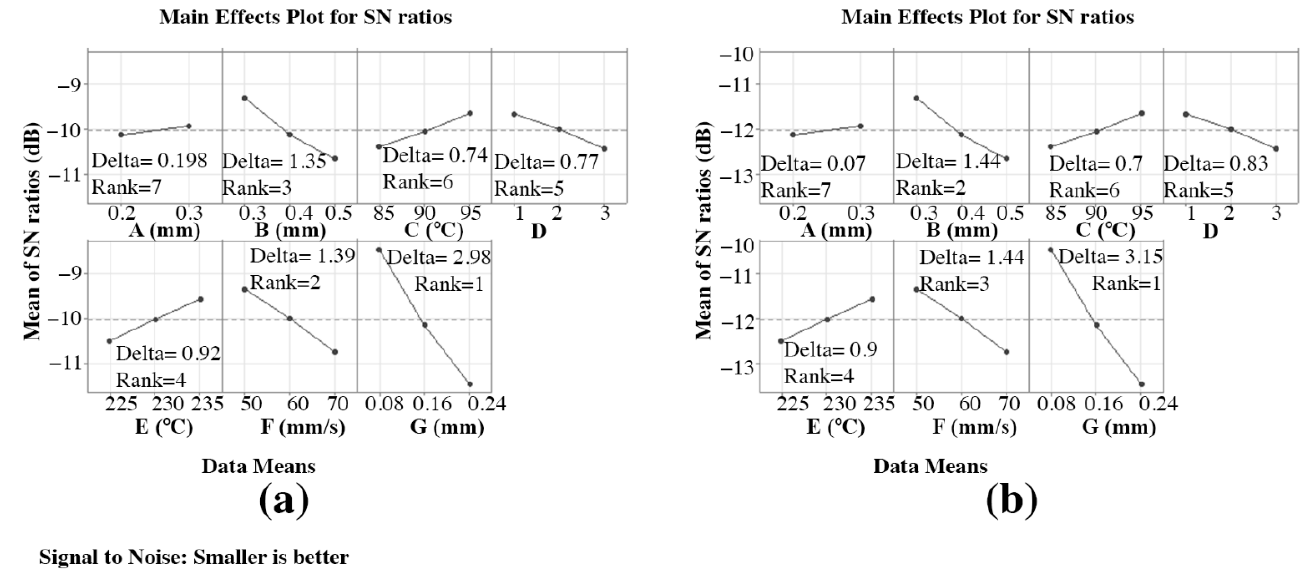
Figure 11. Mean S/N ratio for polymers: ( a ) Ra-ABS and ( b ) Rq-ABS.